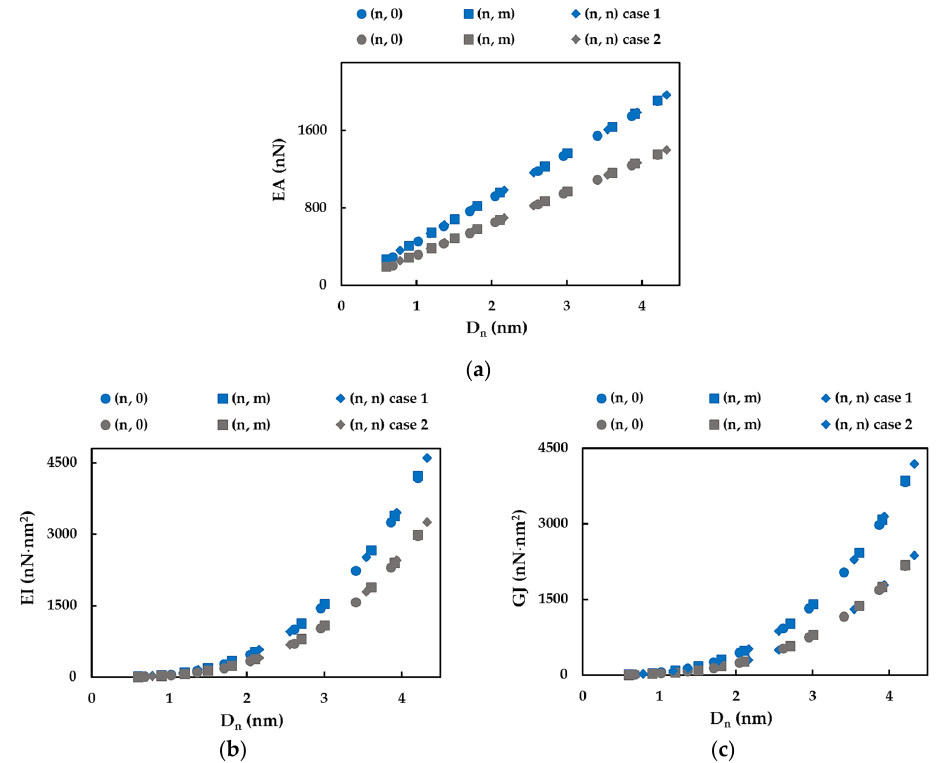
Figure 9. Evolutions of: ( a ) tensile, EA, ( b ) bending, EI, and ( c ) torsional, GJ, rigidities as a function of the NT diameter, D n , for the SWInNNTs in Table 4.